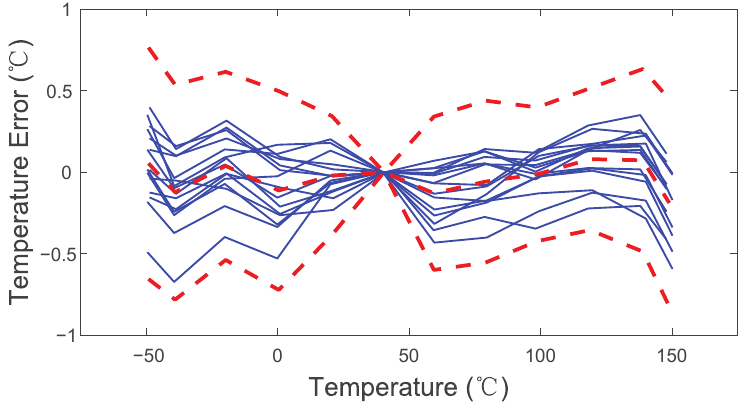
Figure 15. Temperature error of 15 sensors after one-point calibration; red dashed lines refer to the average and 3 σ limits. Table 1. Performance summary and comparison with recently published